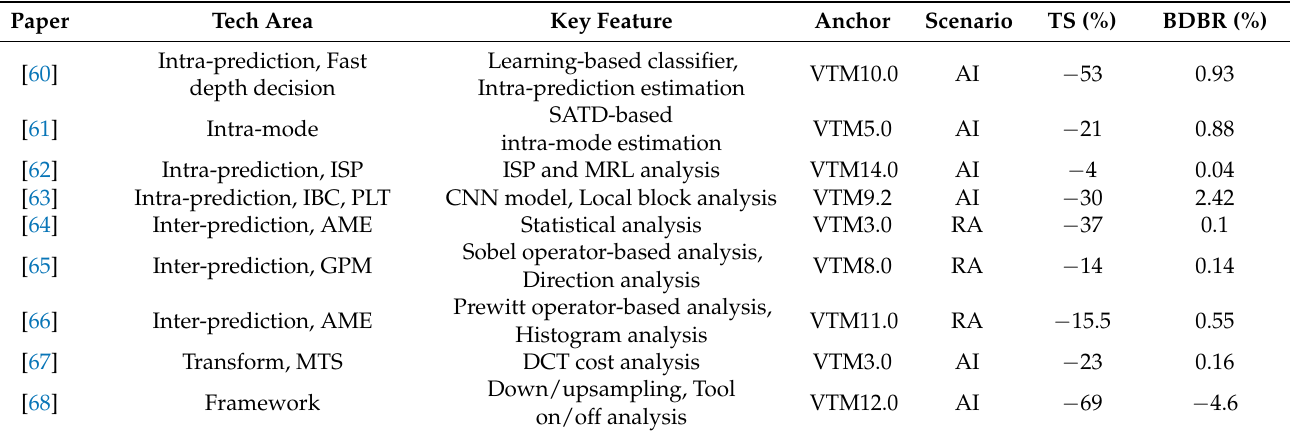
Table 3. Summary of fast tool-based